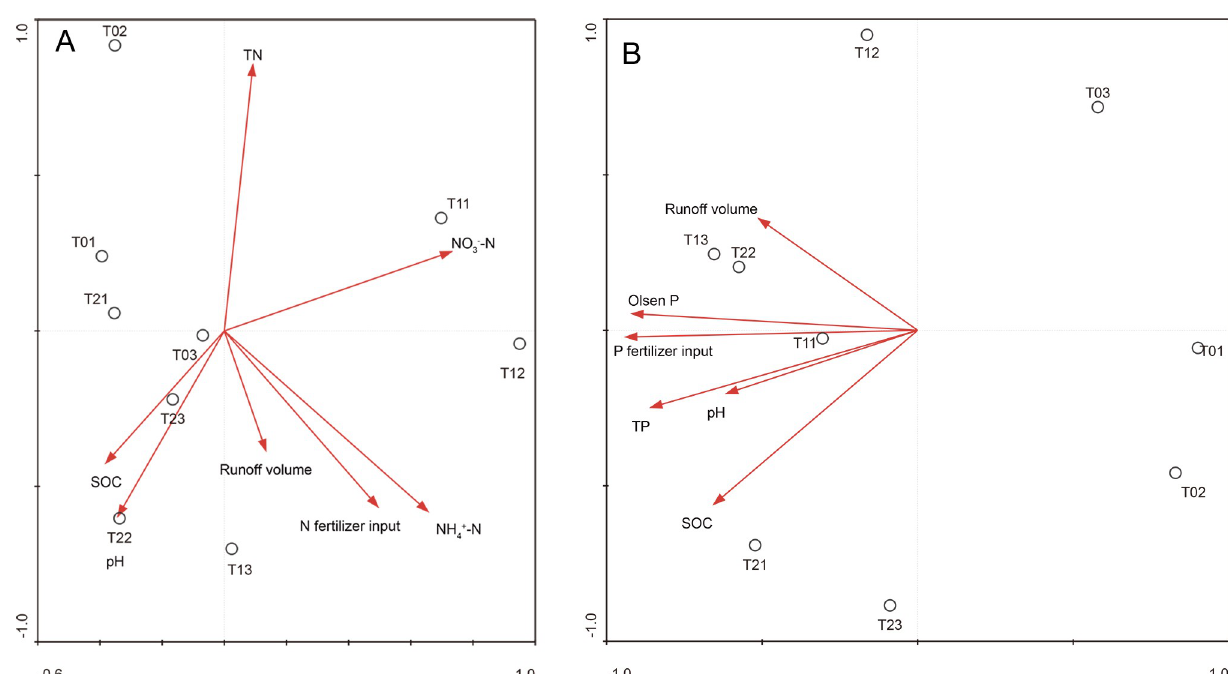
Fig 9. The impact factors determining N/P runoff losses by redundancy analysis (A)/(B). Notes: T0 = Traditional irrigation; T1 = Traditional irrigation and fertilization practice; T2 = Water-saving irrigation and optimizing fertilization. SOC: Soil organic carbon; N: Nitrogen; TN: Total N; NO 3 − − N: Nitrate N; NH 4+ − N: Ammonium N; P: Phosphorus; TP: Total P.